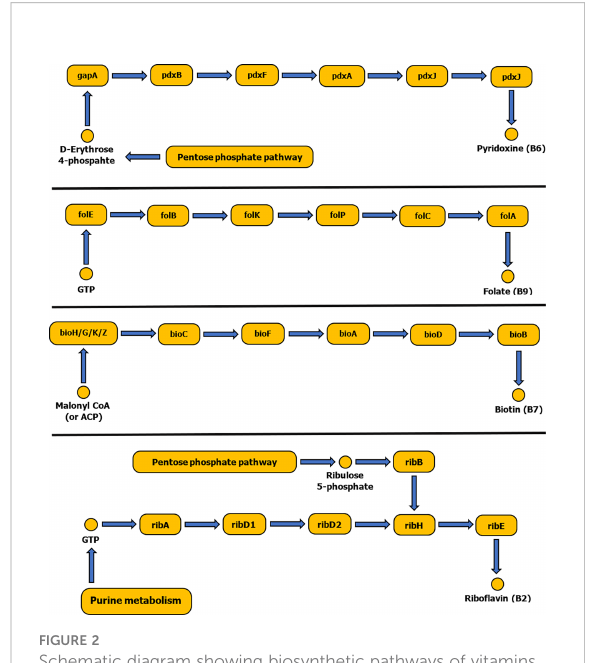
FIGURE 2 Schematic diagram showing biosynthetic pathways of vitamins B6, B9, B7 and B2. Pathways were constructed based on the KEGG reference database and pathways diagrams available in RAST SEED viewer.